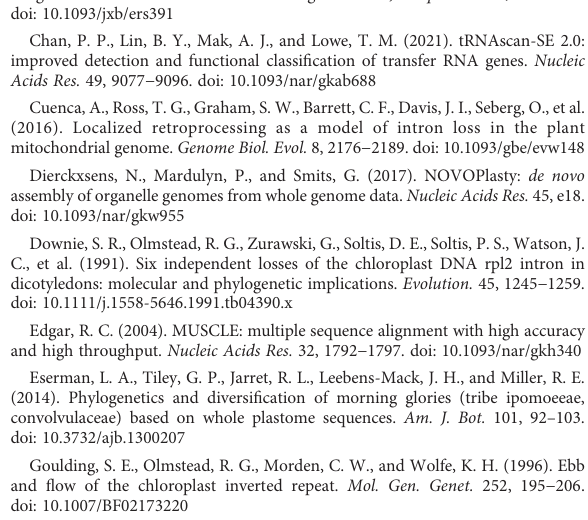
SUPPLEMENTARY FIGURE 1 Plastid phylogenomics of the tribe Ipomoeeae s.l. The tree details the simpli fi ed area depicted in . A 50% majority rule was used to condense the tree topology. Values along branches are bootstrap supports (%) and posterior possibilities for ML and Bayesian inference (BI) trees, respectively. Con fl icting topologies are highlighted with grey. SUPPLEMENTARY FIGURE 2 Dating of taxon divergence time during Convolvulaceae evolution. Black circles indicate nodes with constrained ages. Blue bars denote a range of the 95% highest posterior density (HPD). SUPPLEMENTARY FIGURE 3 Read-mapping and Semi-quantitative PCR demonstrating coexistence of the threedifferent rpl16 copiesanddiscrepancies intheir copynumbersin Dichondra . Primers, rpl16 -LSC-F and rpl16 -LSC-R, were designed to amplify the region containing intronic II − IV domains that are lacking in the rpl16 -IR